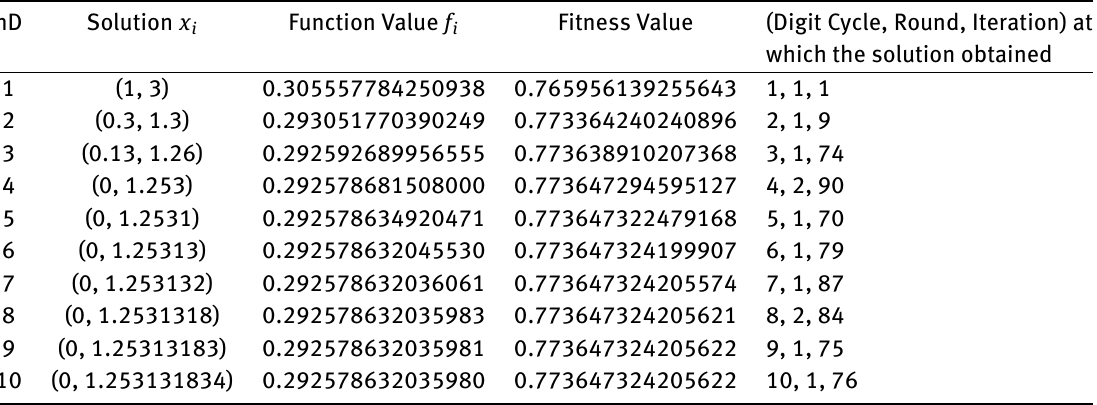
Table 32: Digit Cycle Results for Schaffer 4 function (for precise value finding)